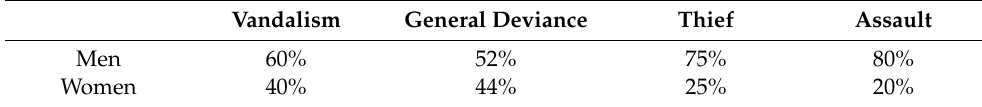
Table 2. Rates of antisocial behaviors in an adolescent